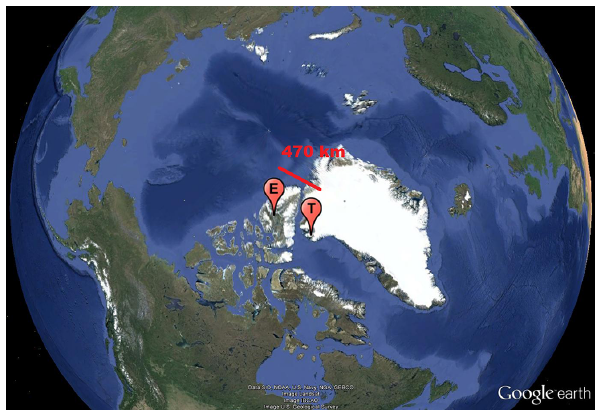
Figure 1. Locations of the FTIR measurements at Eureka (E) and Thule (T) (map provided by GOOGLE EARTH V 7.0.3.8542, US Dept. of State Geographer, Google, 2012, Image Landsat, Data SIO, NOAA, US, Navy, NGA, and